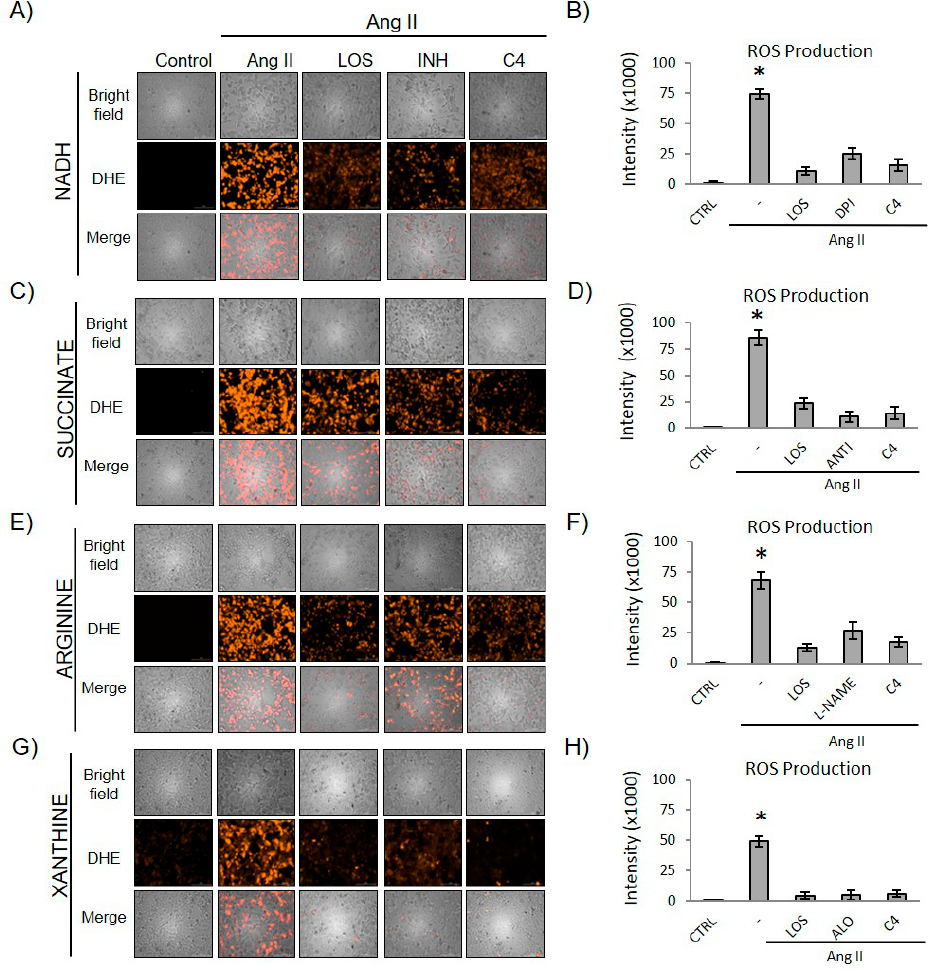
Figure 5. Effect of C4 on the production of O 2 • − from four different reactive oxygen species (ROS) sources, NADH ( A , B ), Succinate ( C , D ), Arginine ( E , F ) and Xanthine ( G , H ). HMEC-1 cells were stimulated with Ang II 5000 nM for 6 h. Representative microphotographs were taken with a 20 × objective ( A , C , E , G ). Data are reported as mean ± SD and were analyzed by ANOVA and the post-hoc Tukey test. n = 5, * p < 0.05 vs. control (Ang II-free), ( B , D , G , H ). LOS: Losartan; INH: Respective inhibitor; C4: Combination of SF1 and SF3, 10 μ g/mL each; DHE: Dihydroethidium; ROS: reactive oxygen species; ALO: allopurinol; CTRL: Control; DPI: Diphenyleneiodonium; NADH: nicotinamide adenine dinucleotide phosphate; ANTI: antimycin; L -NAME: N( ω )-nitro- L -arginine methyl ester.